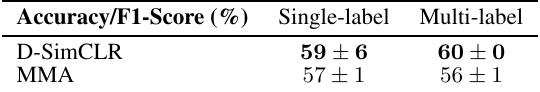
Table 3. Average accuracy and F1-Score (%) of linear probe on single- and multi-label classification on the test